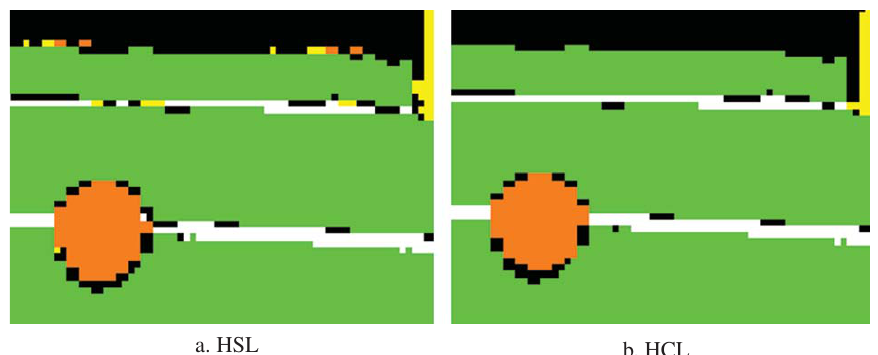
Fig. 13. Colour segmentation results in the HCL and HSL colour